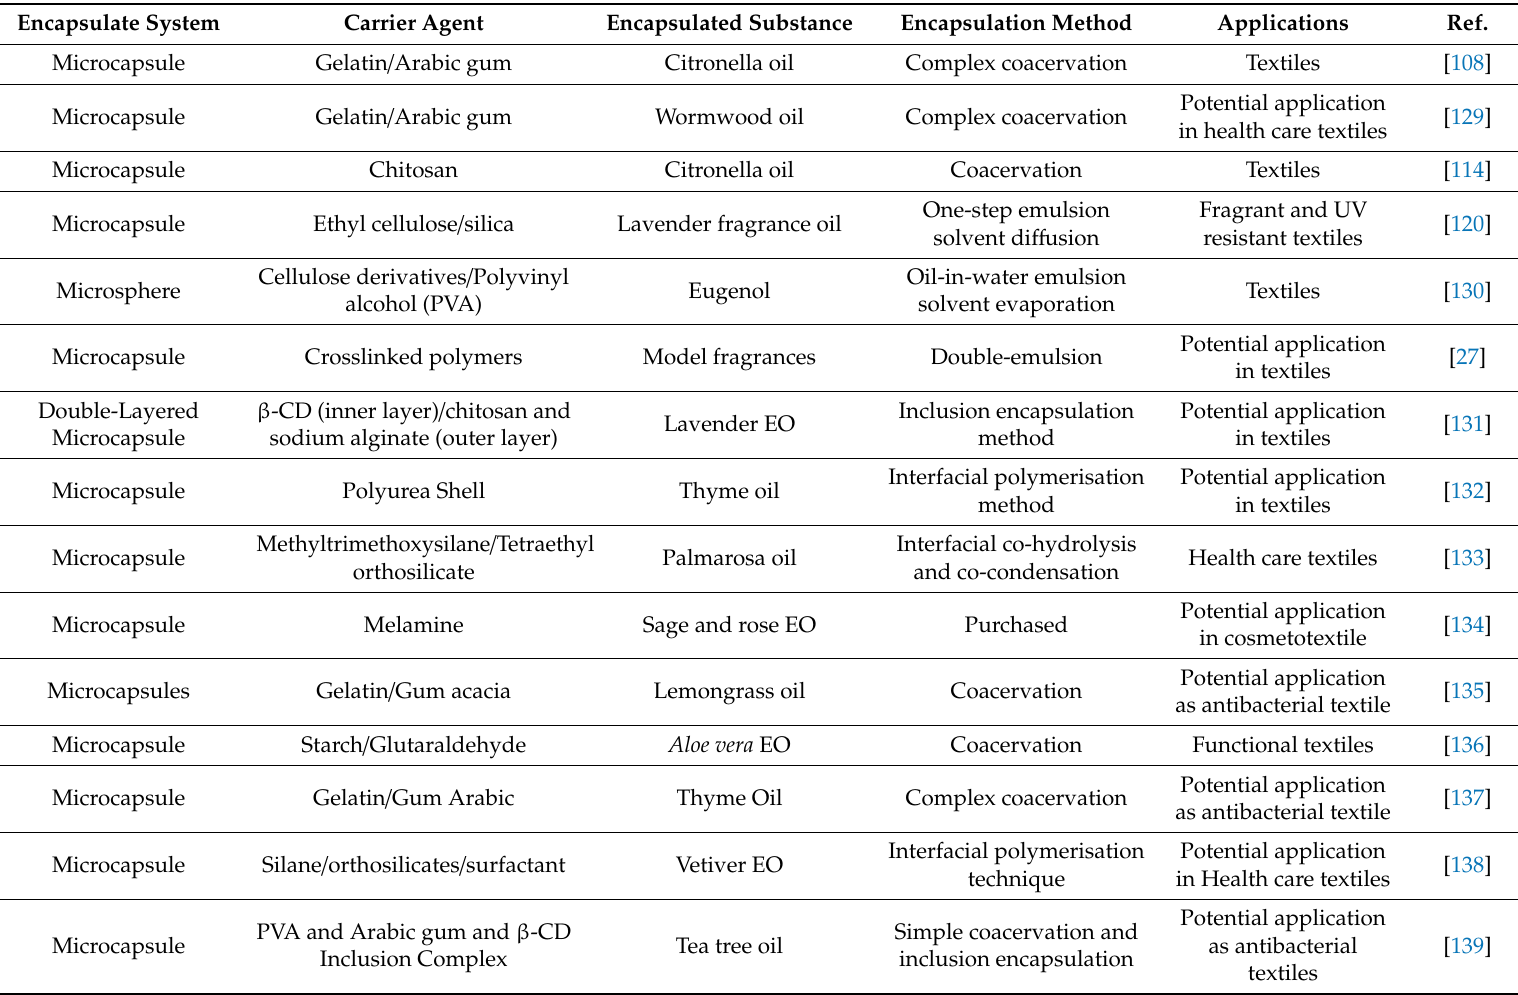
Table 1. Recent studies reporting the microencapsulation of fragrances and flavours for textile applications. EO: essential oil.